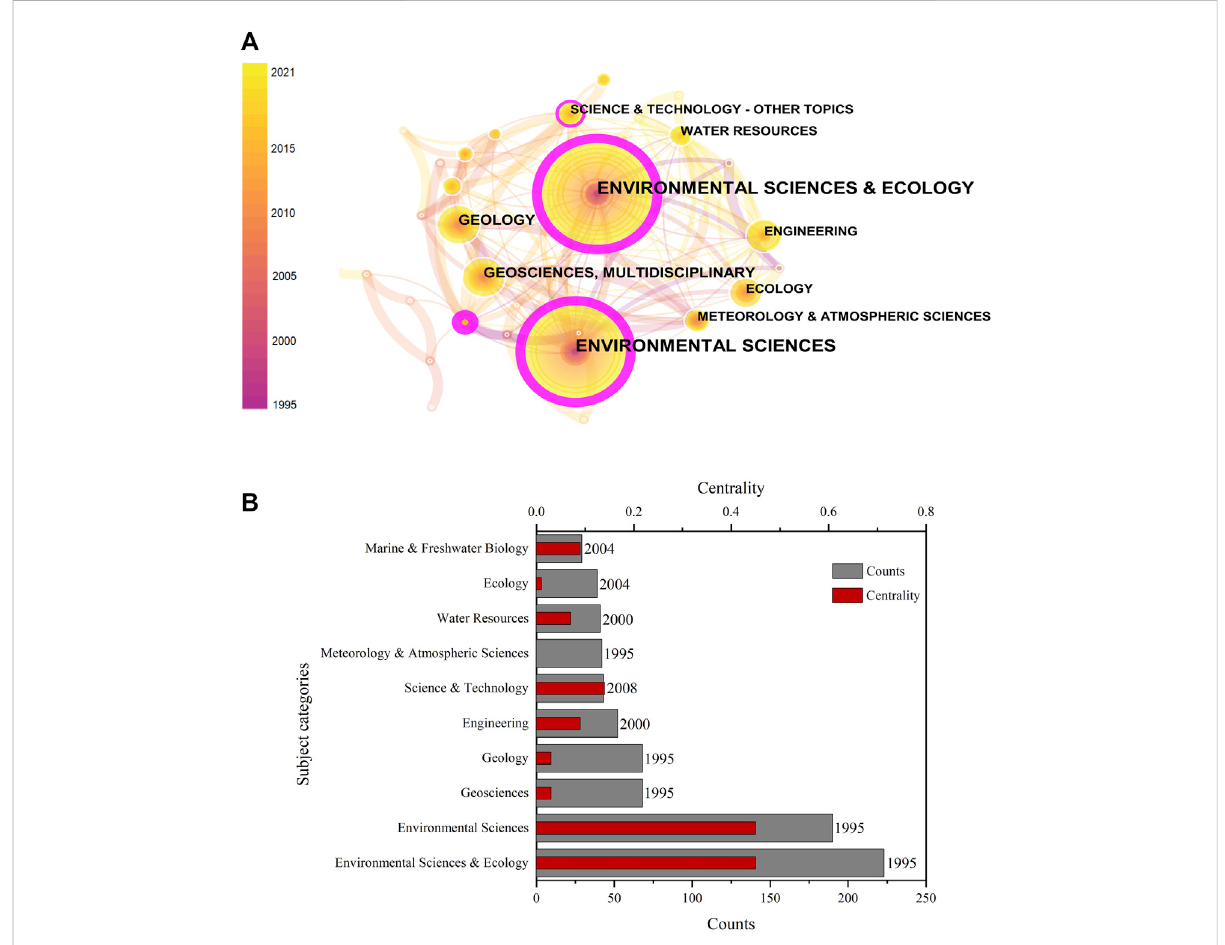
FIGURE 2 Subject categories: (A) Subject categories network; and (B) Top 10 subject categories. The numbers on the bar chart represent the years of the fi rst occurrence.